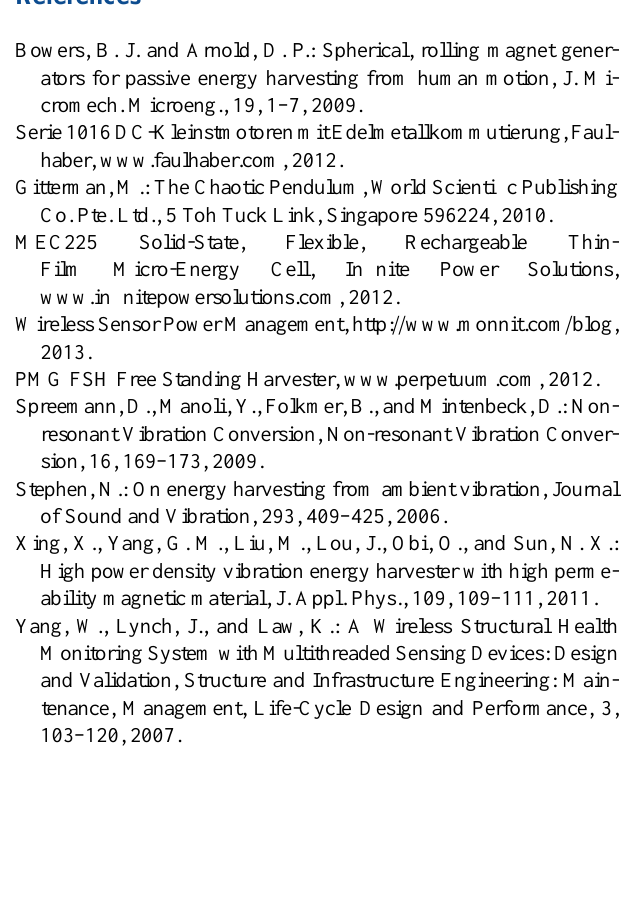
Figure 15. Measured motor speed with respect to frequency and